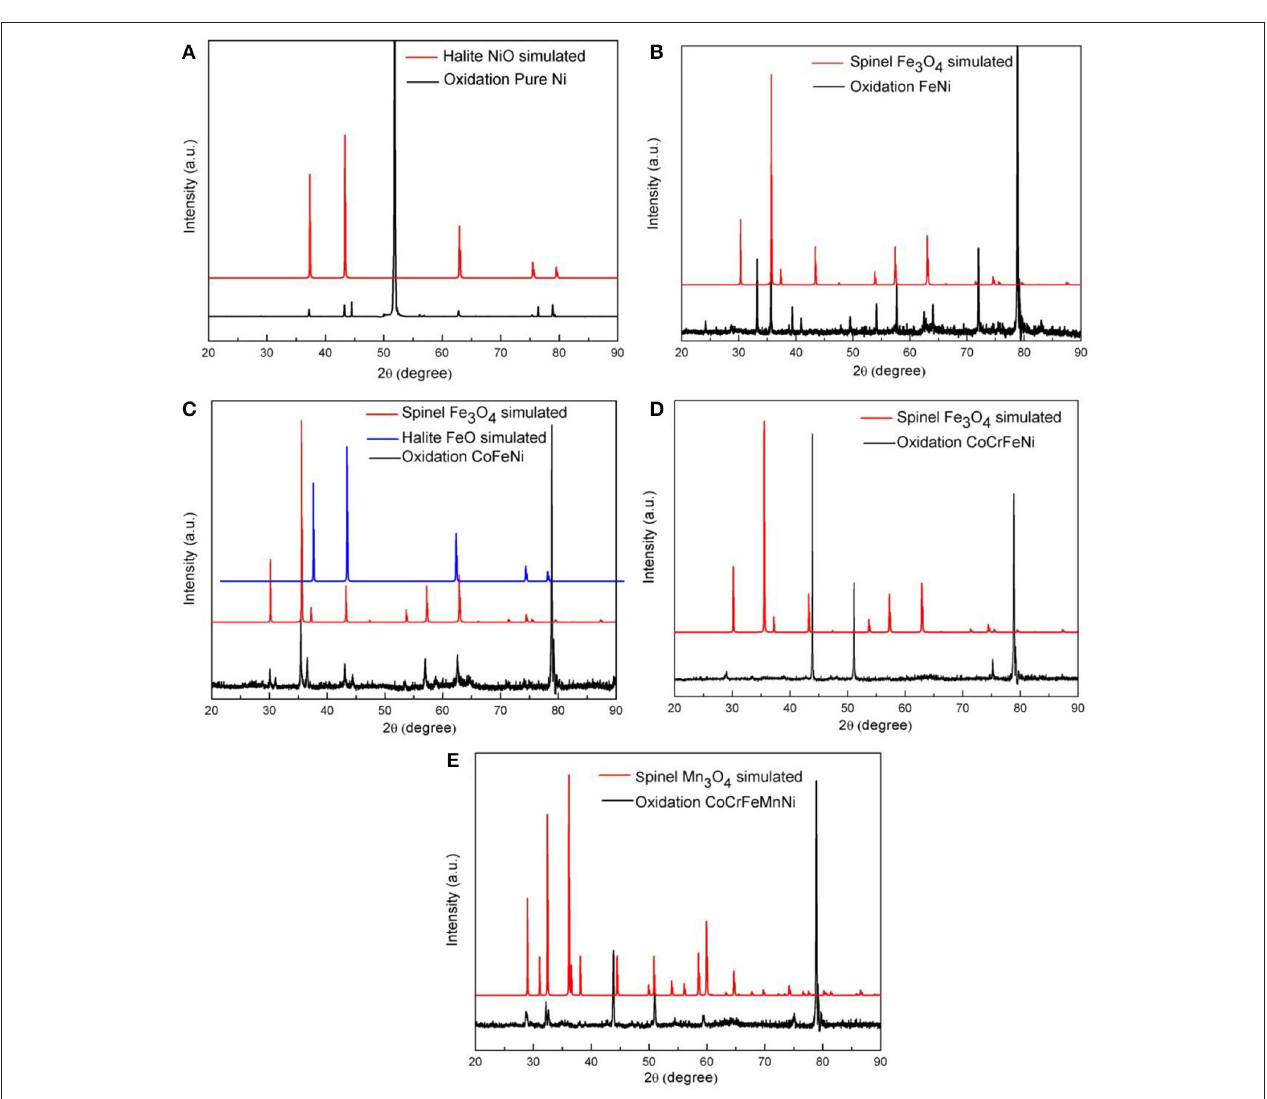
FIGURE 7 | The comparison between the diffractograms of the oxides formed in the oxidation experiments and the simulated diffractograms of the oxides predicted by Calphad modeling. (A) Ni-O; (B) FeNi-O; (C) CoFeNi-O; (D) CoCrFeNi-O; (E) CoCrFeMnNi-O.